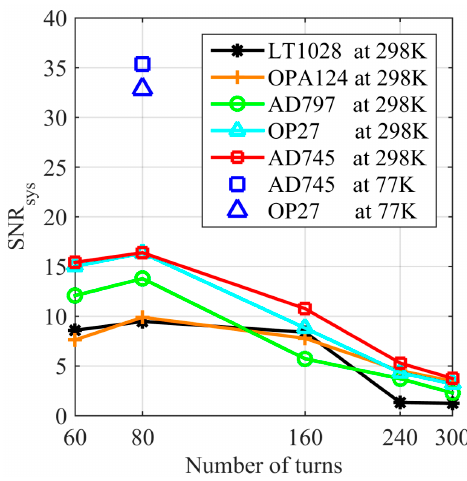
Figure 3. SNR of the coil sensor with different number of turns and preamplifiers.